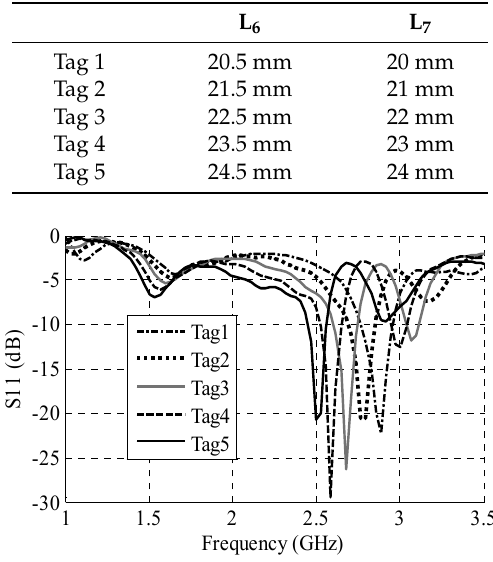
Table 2. L 6 and L 7 dimensions for unique identification.